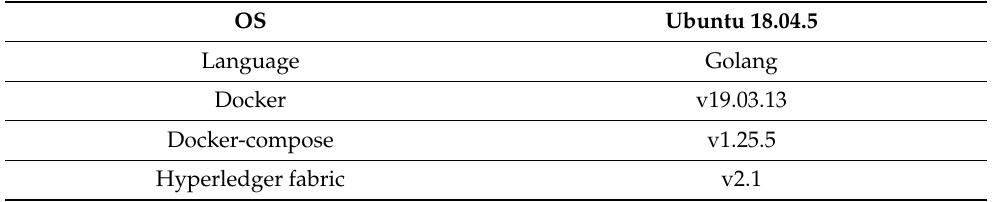
Table 1. Development and Test